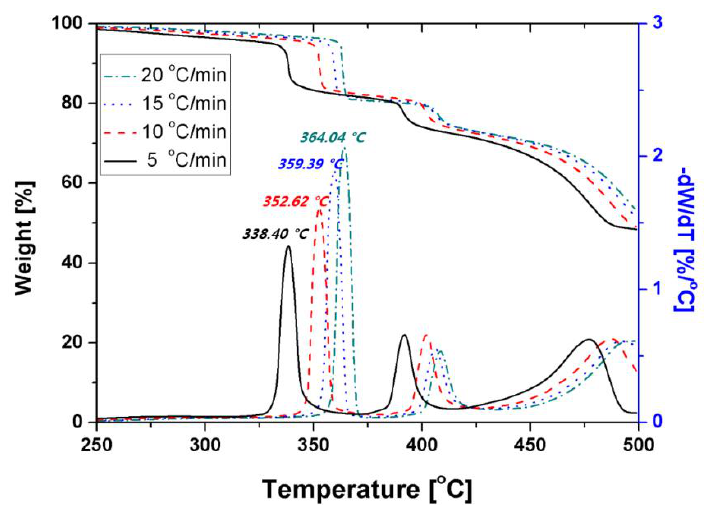
Figure 3. Thermogravimetric (TG) and differential thermogravimetric (DTG) curves of the non-class 1E cable at different heating rates.